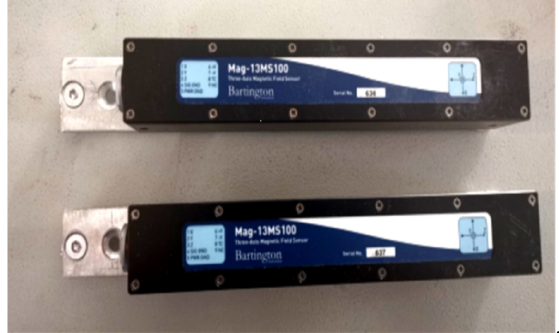
Figure 3. Magnetic field information collector.